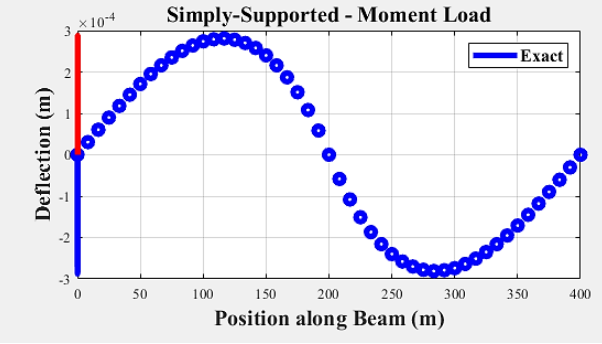
Fig. 14. Direction of total deformation (0.000299 mm) of Cemented Carbide simply supported beam with centre load of 100 N.mm by MATLAB